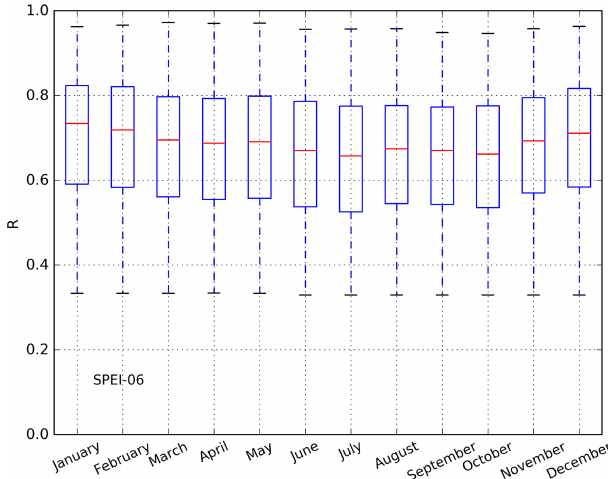
Figure 3. Box plot of the correlation ( p < 0 . 05) between SPEI-HR and SPEI-CRU for each month of the entire record. The results here are based on 6-month SPEI, and the red line in each box represents the